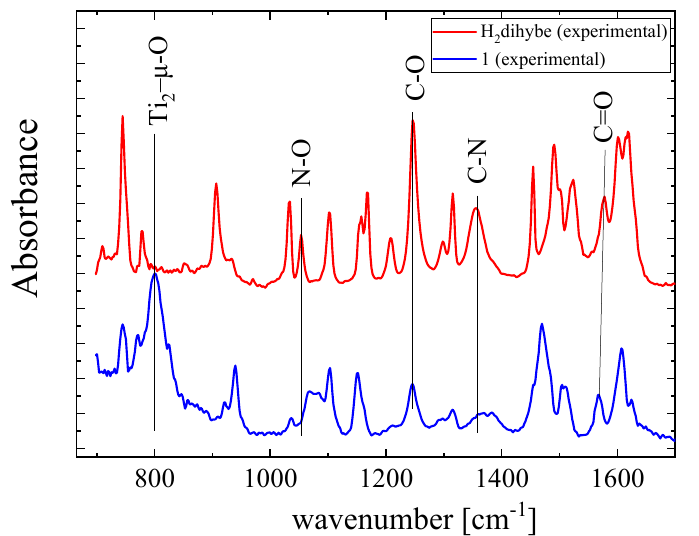
Figure 5. Experimental IR absorbance spectra of the ligand N ,2-Dihydroxybenzamide denoted as H 2 dihybe and titanium(IV) complex with N ,2-dihydroxybenzamide denoted as 1 .